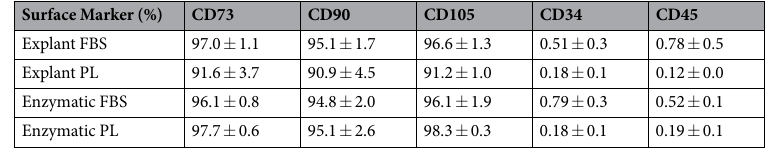
Table 1. Surface marker expression of umbilical cord tissue derived mesenchymal stem cells cultured in FBS and PL supplements assessed by flow cytometric analysis at P2. Data presented as mean percentage ± SEM of three independent experiments. Statistical comparisons were made within explant and enzymatic groups respectively. There was no statistical significant difference noted within the